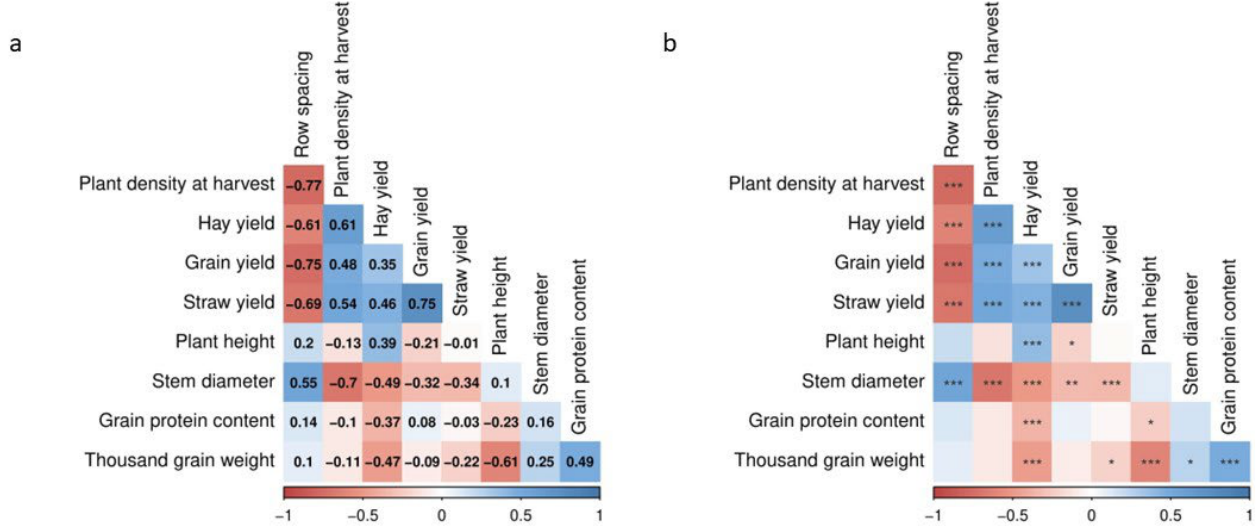
Figure 1. Pearson’s correlation coefficients among plant density, growth, yield, and grain-quality parameters of quinoa. Blue and red colors represent positive and negative correlations, respectively. ( a ) Pearson’s correlation values. ( b ) Significance of Pearson’s correlation values (* p < 0.05, ** p < 0.01, *** p < 0.001). Colors reflect correlation values between every two variables. Each value represents measurements from 96 plots for all three different row spacings during the years of the experiment (four sowing dates).